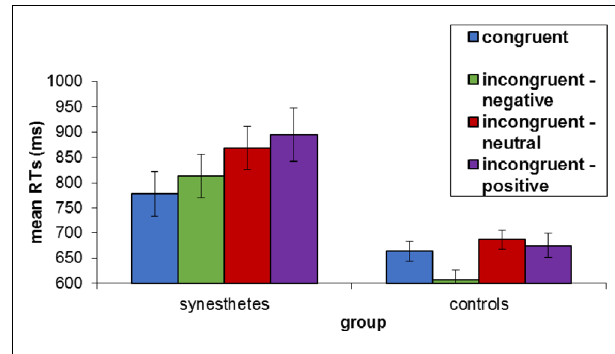
FIGURE 4 | Mean RT for synesthetes (AD and BM) and control groups in the different congruity conditions (congruent, incongruent negative, incongruent neutral, and incongruent positive) in Experiment 1. Error bars denote standard error of the